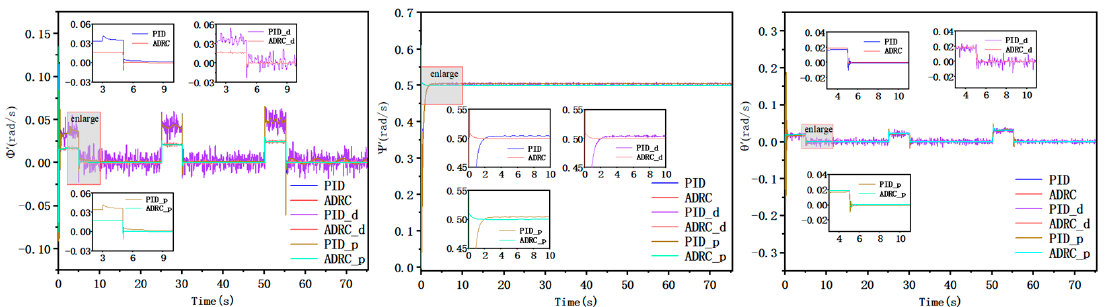
Figure 16. Roll, yaw, pitch angular rate response.